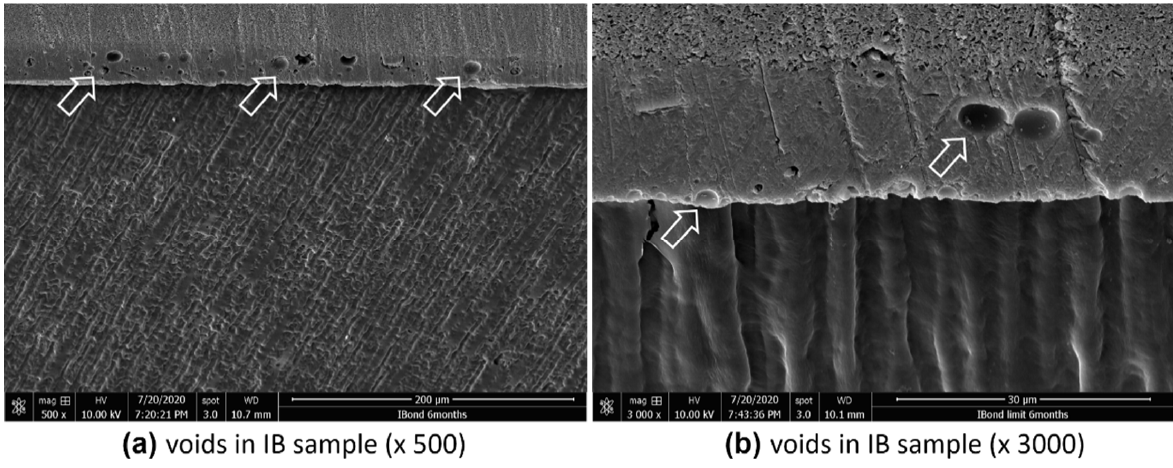
Figure 4. Representative photos of scanning electron microscopy showed the voids into the IBond Universal adhesive layer (white arrows) after a 6-months water-storage period at 37 °C. ( a ): x500 magnification; ( b ): x3000 magnification.